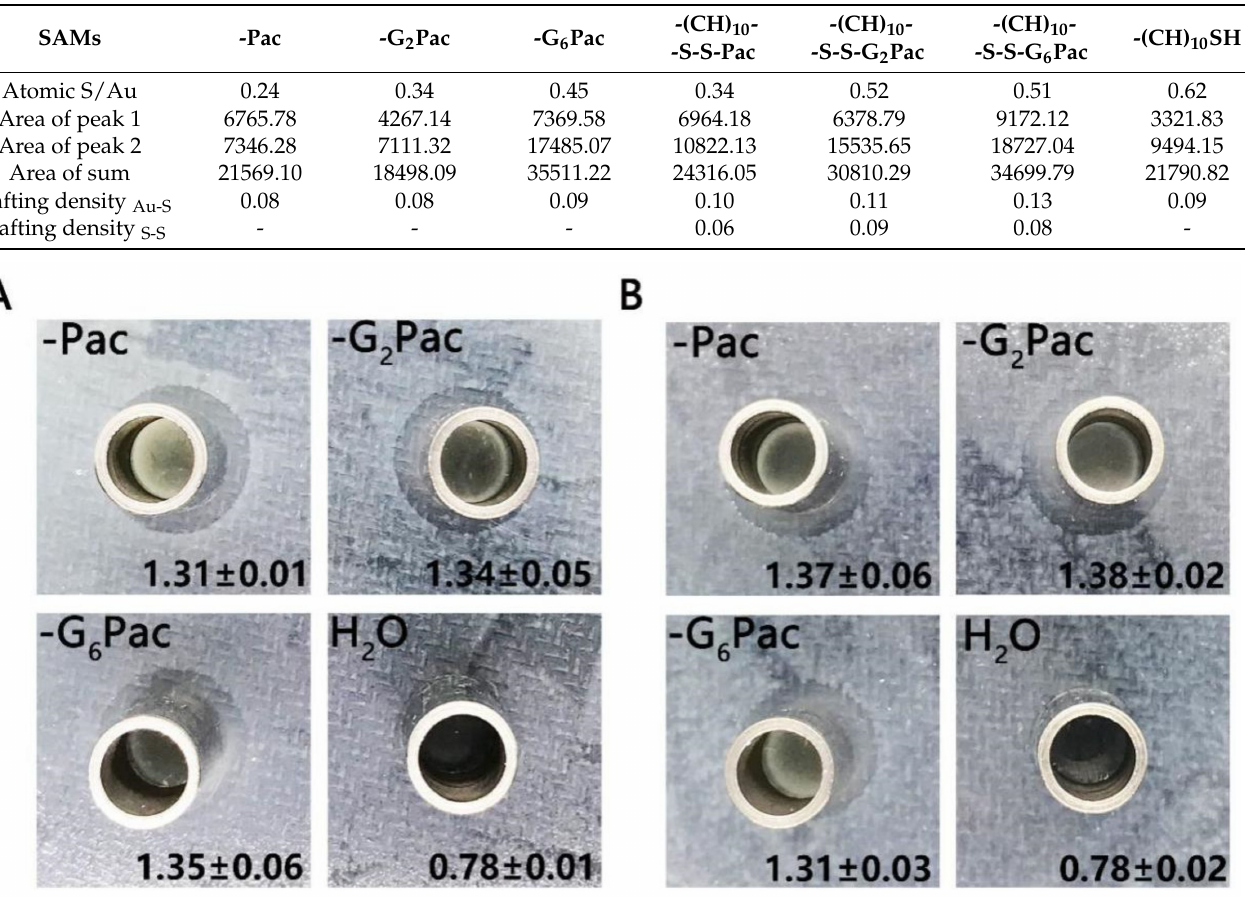
Figure 3. The antibacterial ability of the Pac-525 derivatives by the inhibition zones assay against E. coli ( A ) and S. aureus ( B